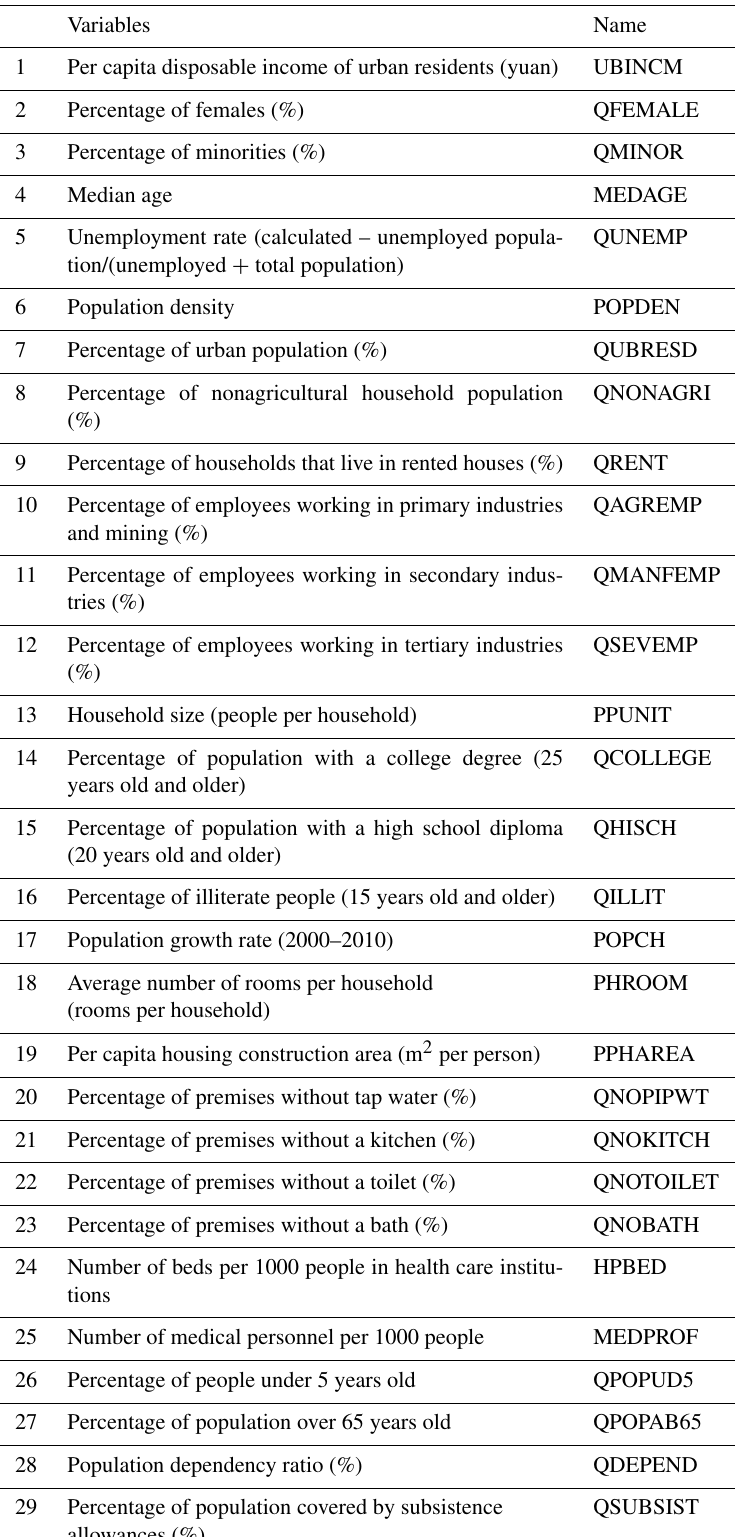
Table 2. The 29 variables affecting vulnerability in Zhejiang